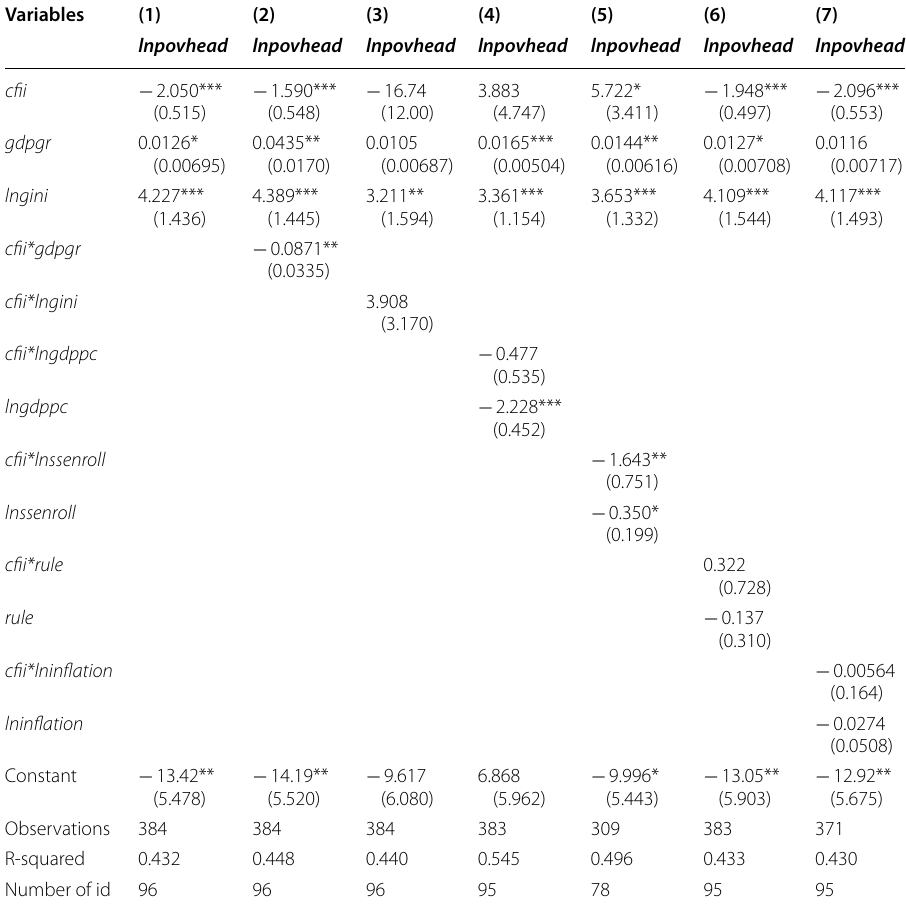
Table 5 Conditional effects of financial inclusion on poverty (fixed effect estimation)